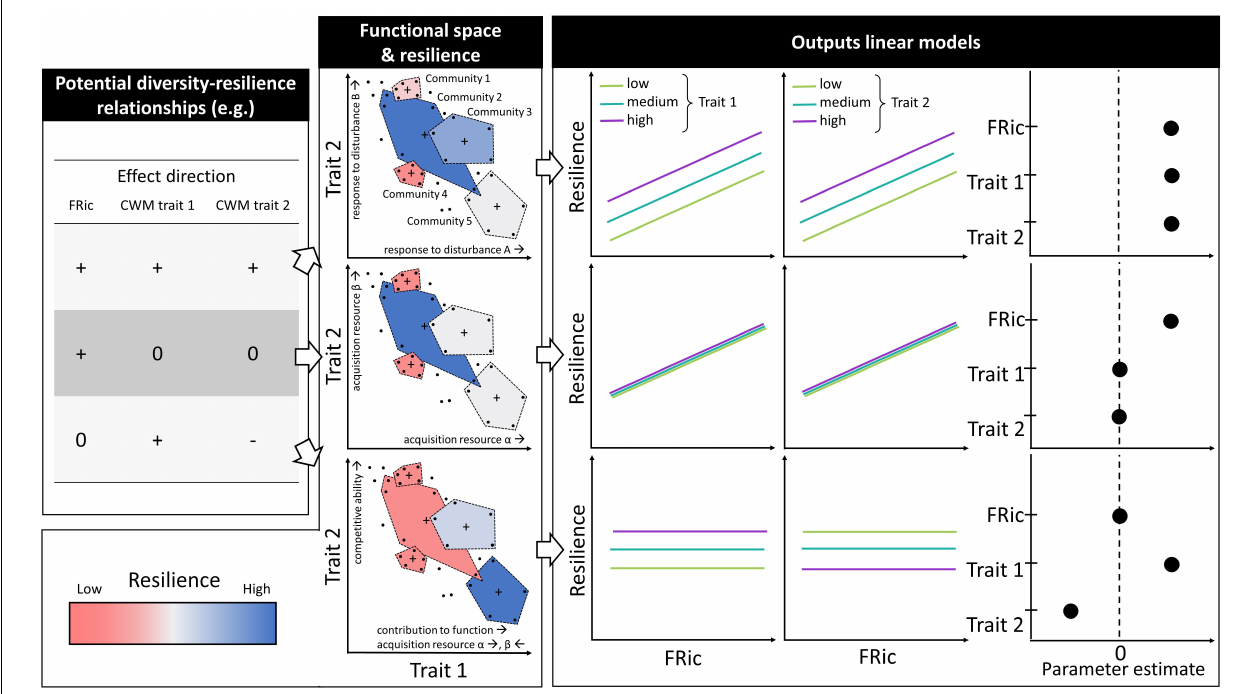
FIGURE 1 | Examples of potential effect directions of functional richness (FRic) and community weighted mean (CWM) of traits on resilience, with corresponding idealized outputs from linear models, including bivariate relationships and parameter estimates. Each of the plots under “Functional space and resilience” show the same four communities (polygons), each of which comprises five species (black dots) and have different CWM of traits (crosses) and FRic (area of polygons). The functional space is defined by only two traits for simplicity, and these two traits are negatively correlated. The color of the community polygons represents their resilience, which depends on the sign of the effect of FRic and the CWM of traits (table on the left). The green, turquoise and purple lines represent idealized model fits with one trait set to a low, medium and high value, respectively, and the other trait set to a medium value. Interactions between FRic and CWM of traits are not depicted here but are included in the results. The figure depicts three scenarios where FRic and CWM of traits have different effects on resilience due to different mechanisms and trait compositions: the insurance effect with two response traits associated to disturbances A and B, respectively (upper panels) ; the complementarity effect with two traits involved in the acquisition resources α and β , respectively (middle panels) ; the offsetting combination of the dominance and complementarity effects with trait one involved in the contribution to a function and also in the acquisition of resources α and β (bottom panels) , and trait two a competitive trait (see text for